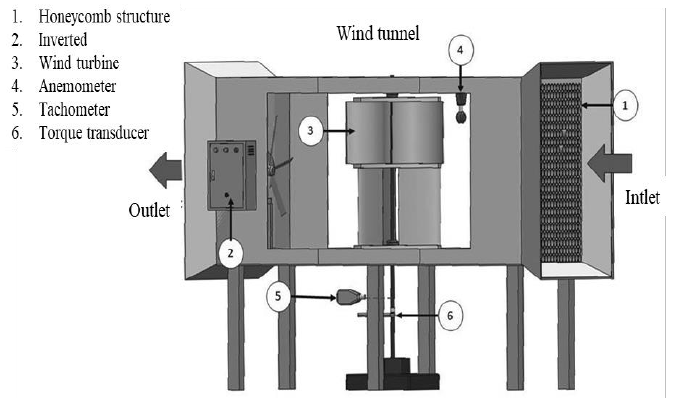
Figure 11. Schematic diagram of wind tunnel experimental apparatus.